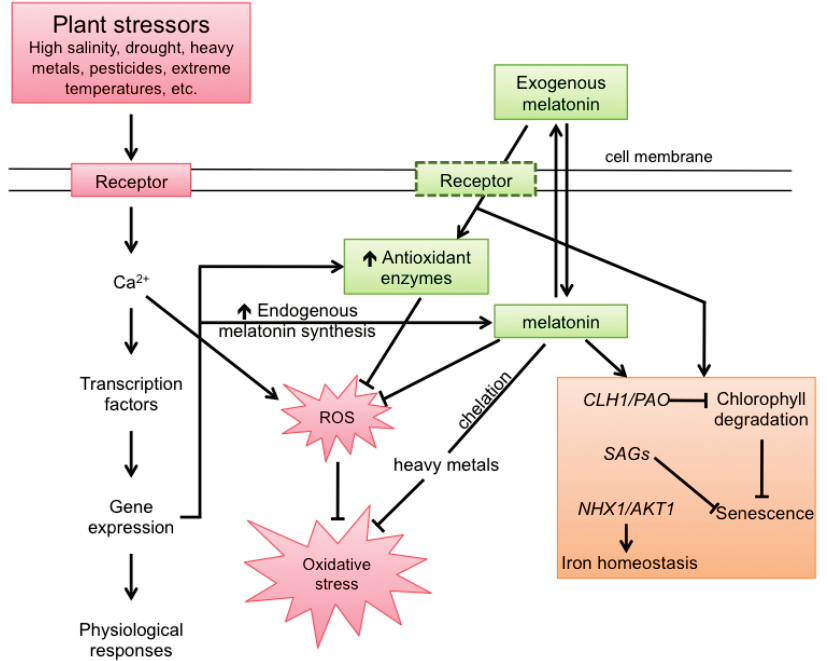
Figure 7. Abiotic stresses negatively impact plant physiology. These stressors induce